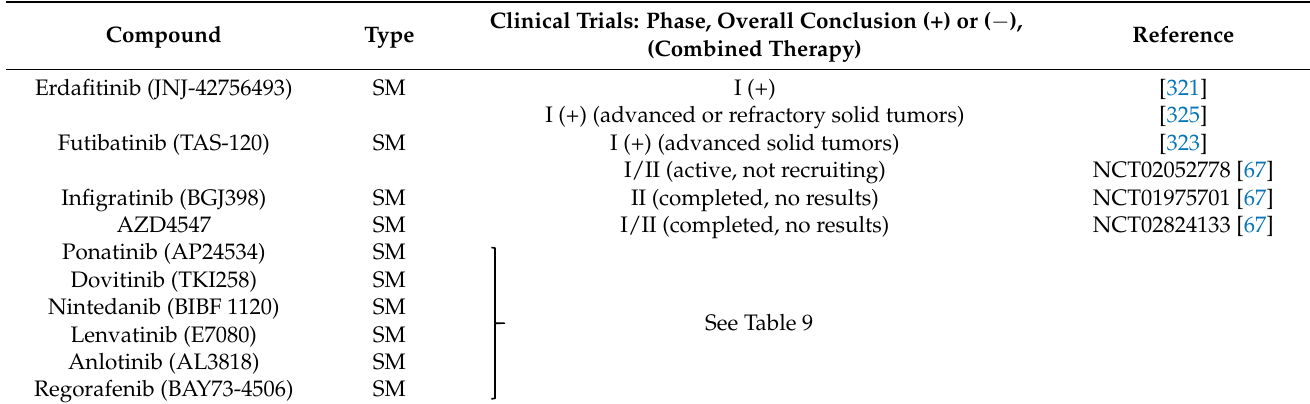
Table 7. Clinical trials in GB targeting the fibroblast growth factor receptor.